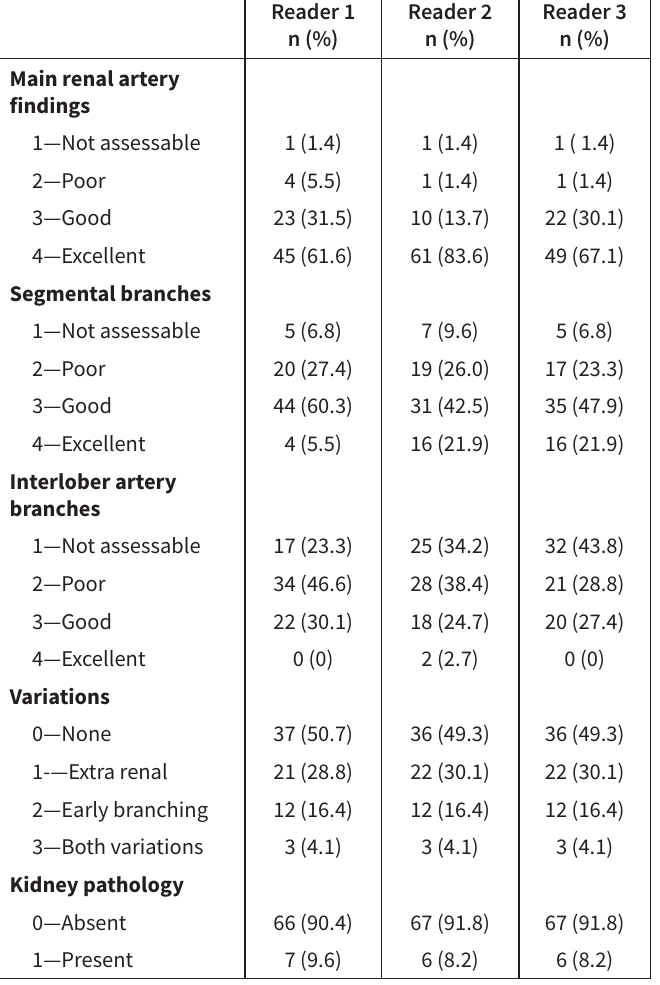
Table 1. Image Quality Scores of Renal Artery and Its Branches,